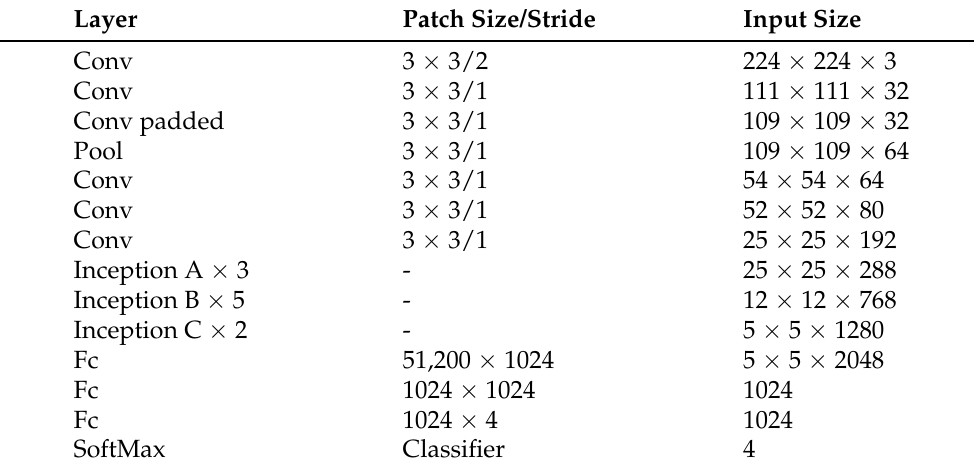
Figure 4. The Inception-V3 modules: A, B and C. Inception-V3 modules are based on convolution and pooling layers. “n” indicates a convolution layer and “m” indicates a pooling layer. n and m are the convolution dimensions [31]. Table 2. Inspection-V3’s architecture used in this paper